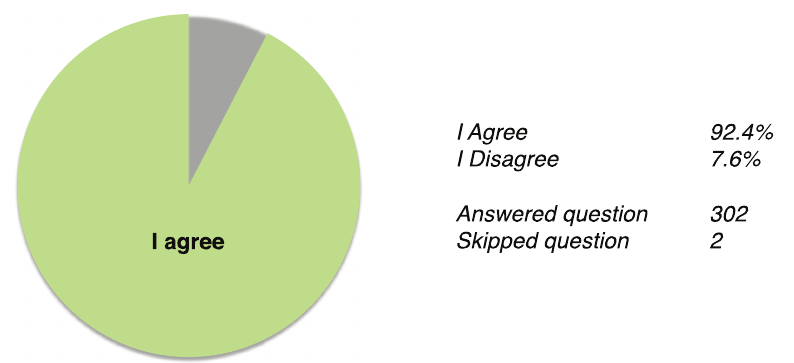
Figure S4. The vast majority of basic scientists think that public funding for basic biological/biomedical research should be increased, despite the current economic situation.